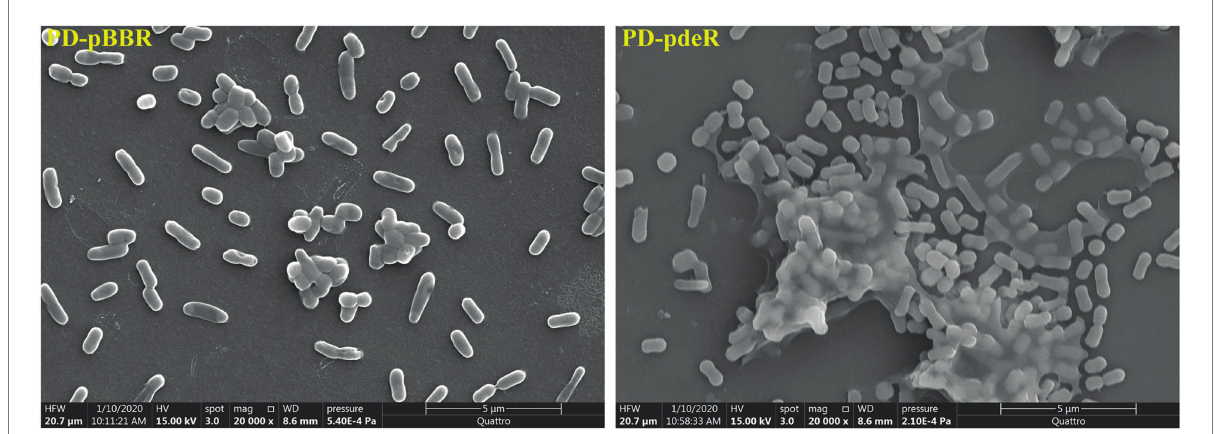
FIGURE 3 The morphology of PD-pBBR and PD-pdeR using SEM (scale bar = 5 μ m). Cells were incubated in LB medium for 36 h, the glass slides that were pre-placed in 24-well plates were directly processed for Scanning Electron Microscope (SEM)